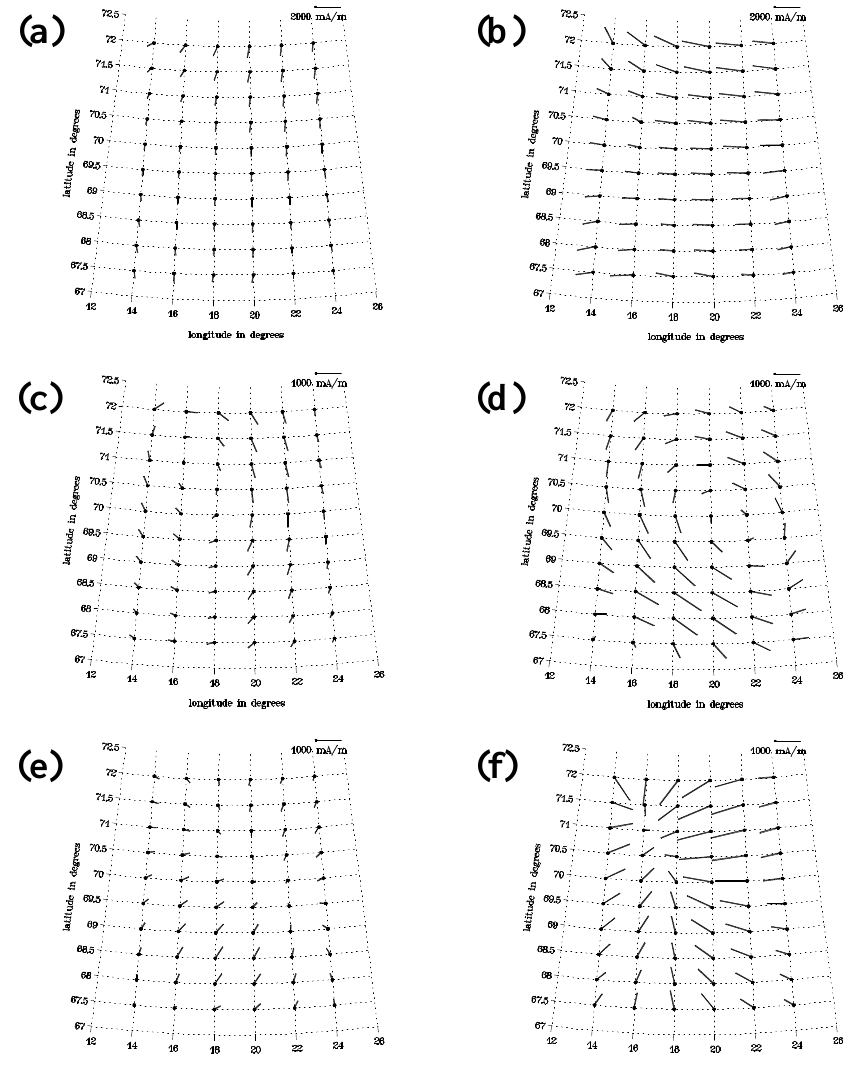
Fig. 7. Decomposition of the true ionospheric currents J at 03:23 UT into a part which is curl- and divergence-free in the analysis area (“lap”, upper row), a part which is divergence-free but has curls in the analysis area (“df”, middle row), and a part which is curl-free but has divergences in the analysis area (“cf”, lower row), seperately performed for the Pedersen currents J P (left column) and the Hall currents J H (right